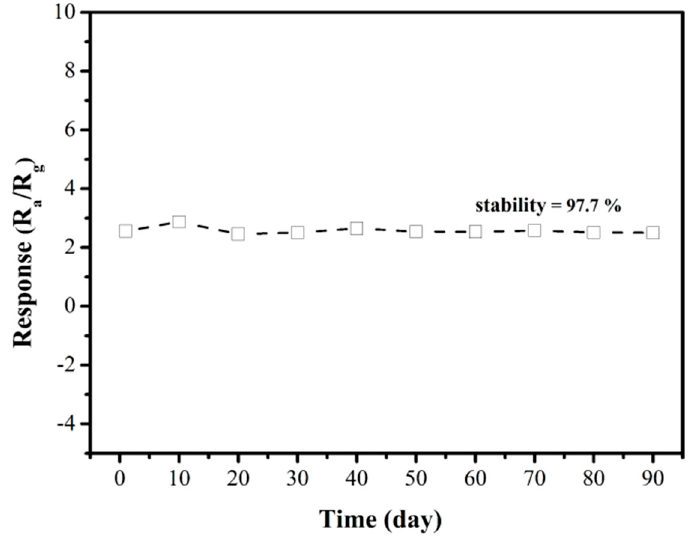
Figure 11. Long-term stability of the CNZ-3 sensor towards 500 ppm CH 4 at 320 °C.